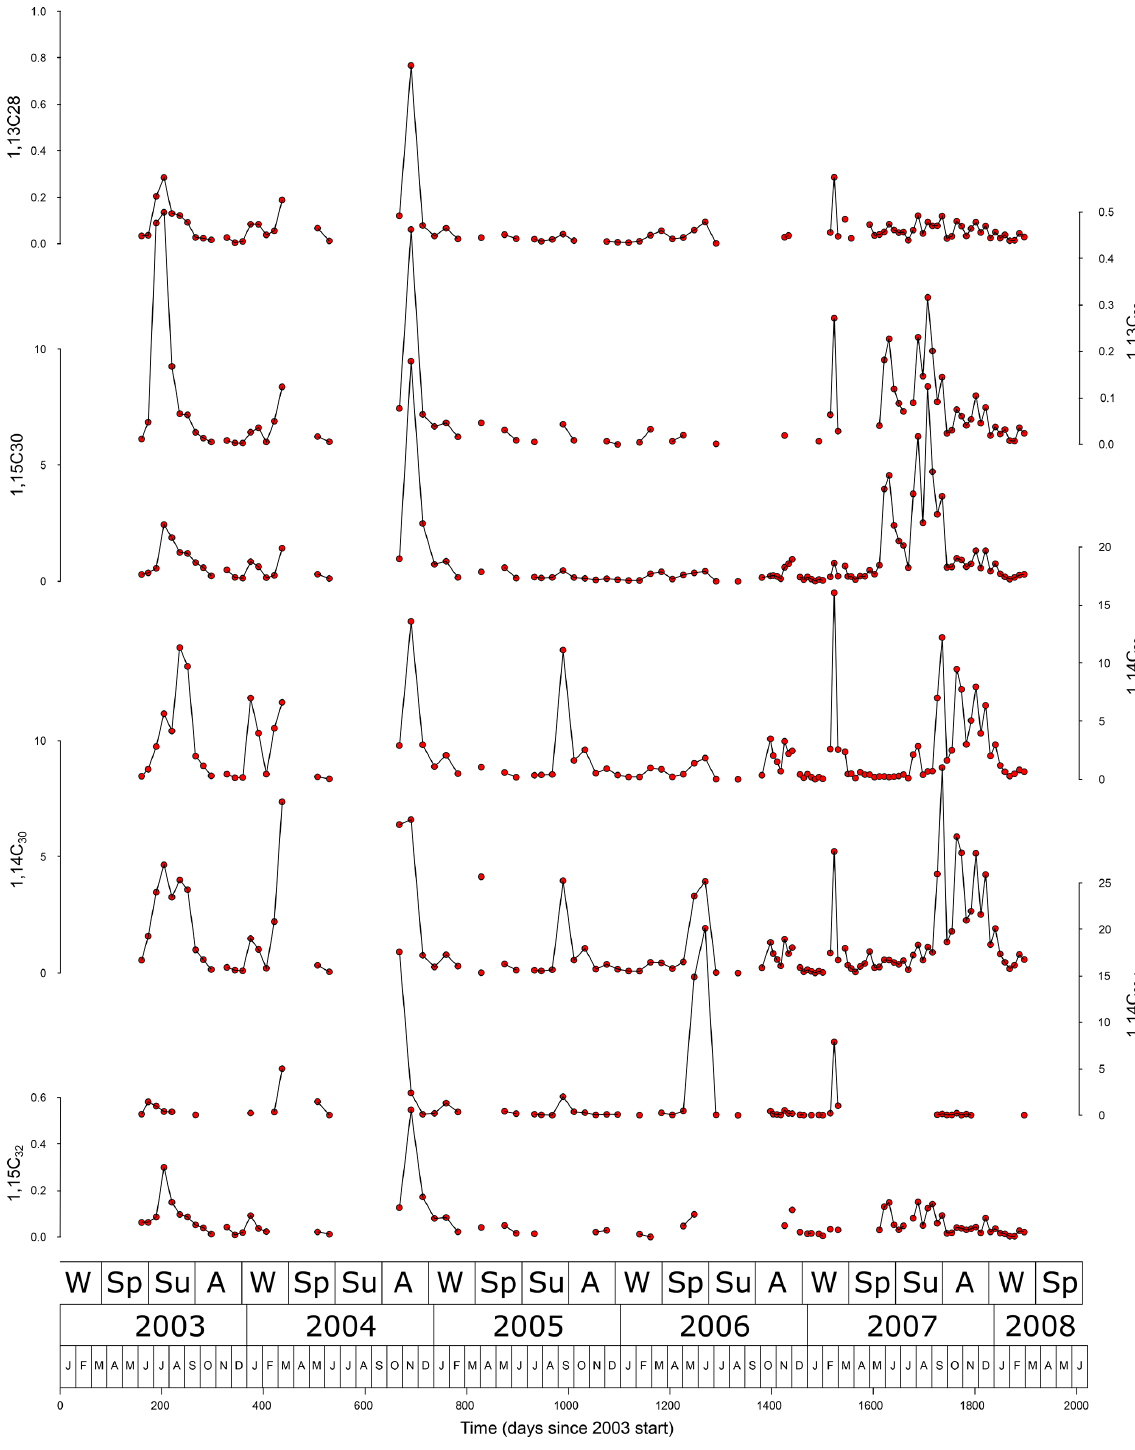
Figure 10. Fluxes for individual diols in µgm − 2 d − 1